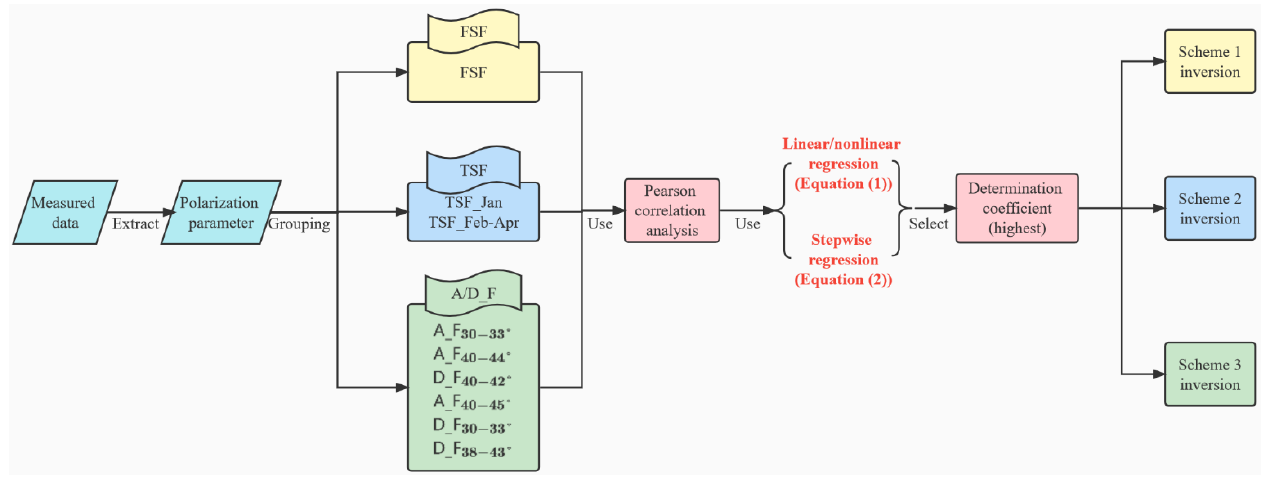
Figure 4. Main scheme framework. FSF means all samples are fitted; TSF_Jan means that data measured in January are fitted, where Jan denotes January; TSF_Feb–Apr means that data measured in February, March, and April are fitted (the river ice thickness is 0 in April in the Babao River); and in scheme 3, A_F 30–33° , A_F 40–44° , and D_F 40–42° are the Babao River fitting equations, and A_F 40–45° , D_F 30–33° , and D_F 38–43° are the Binggou River fitting equations (for example, in A_F 30–33° , A means ascending orbit, D means descending orbit, F denotes fitting, and 30–33° is the radar image incidence angle range).